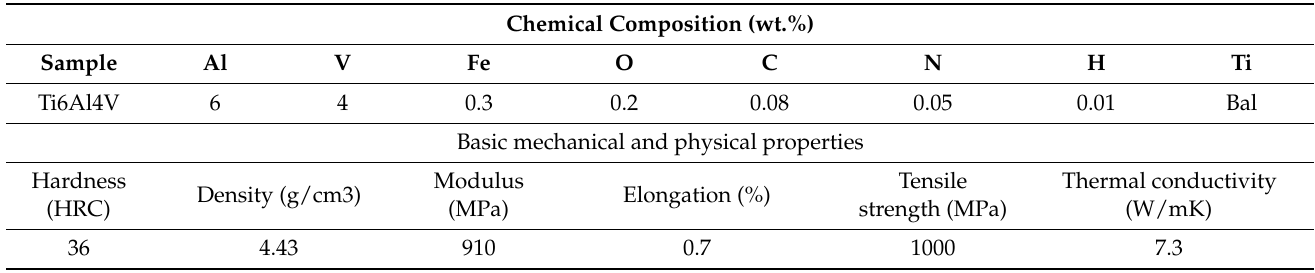
Table 1. The chemical composition and mechanical and physical properties of Ti6Al4V [40]. Chemical Composition